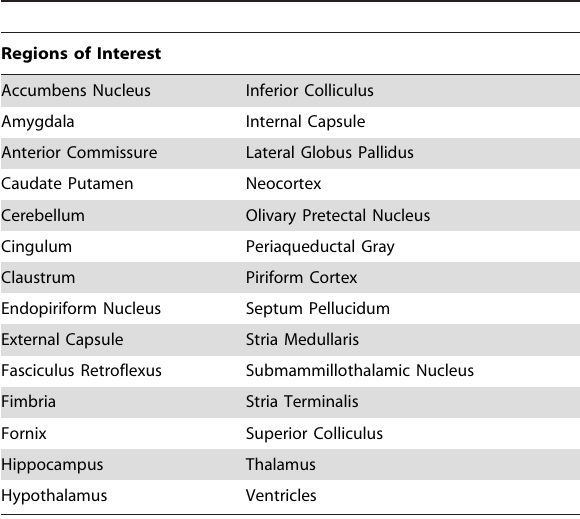
Table 1. Regions of Interest Imaged Via MRI in the Brains of 6-Month Old Male and Female